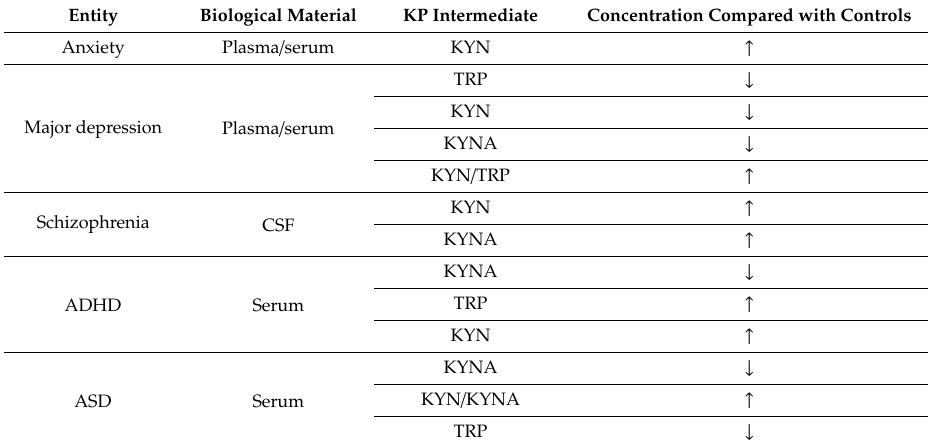
Table 2. Kynurenine (KP) intermediates in psychiatric diseases [154,164]. Entity Biological